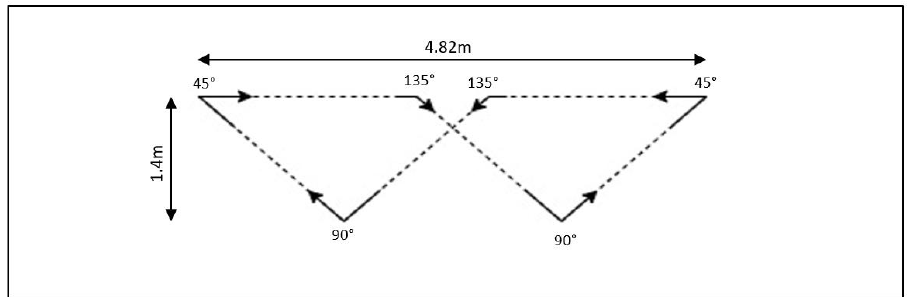
Figure 2. The turning course for Task 1.